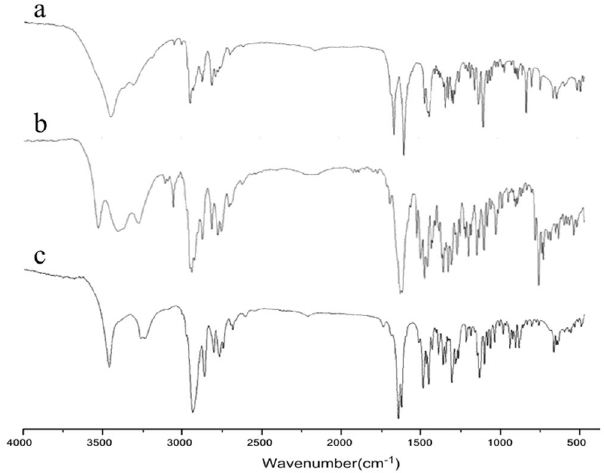
Figure 4. IR spectrum of sophocarpine ( a ), and matrine derivatives 1 ( b ) and 2 ( c